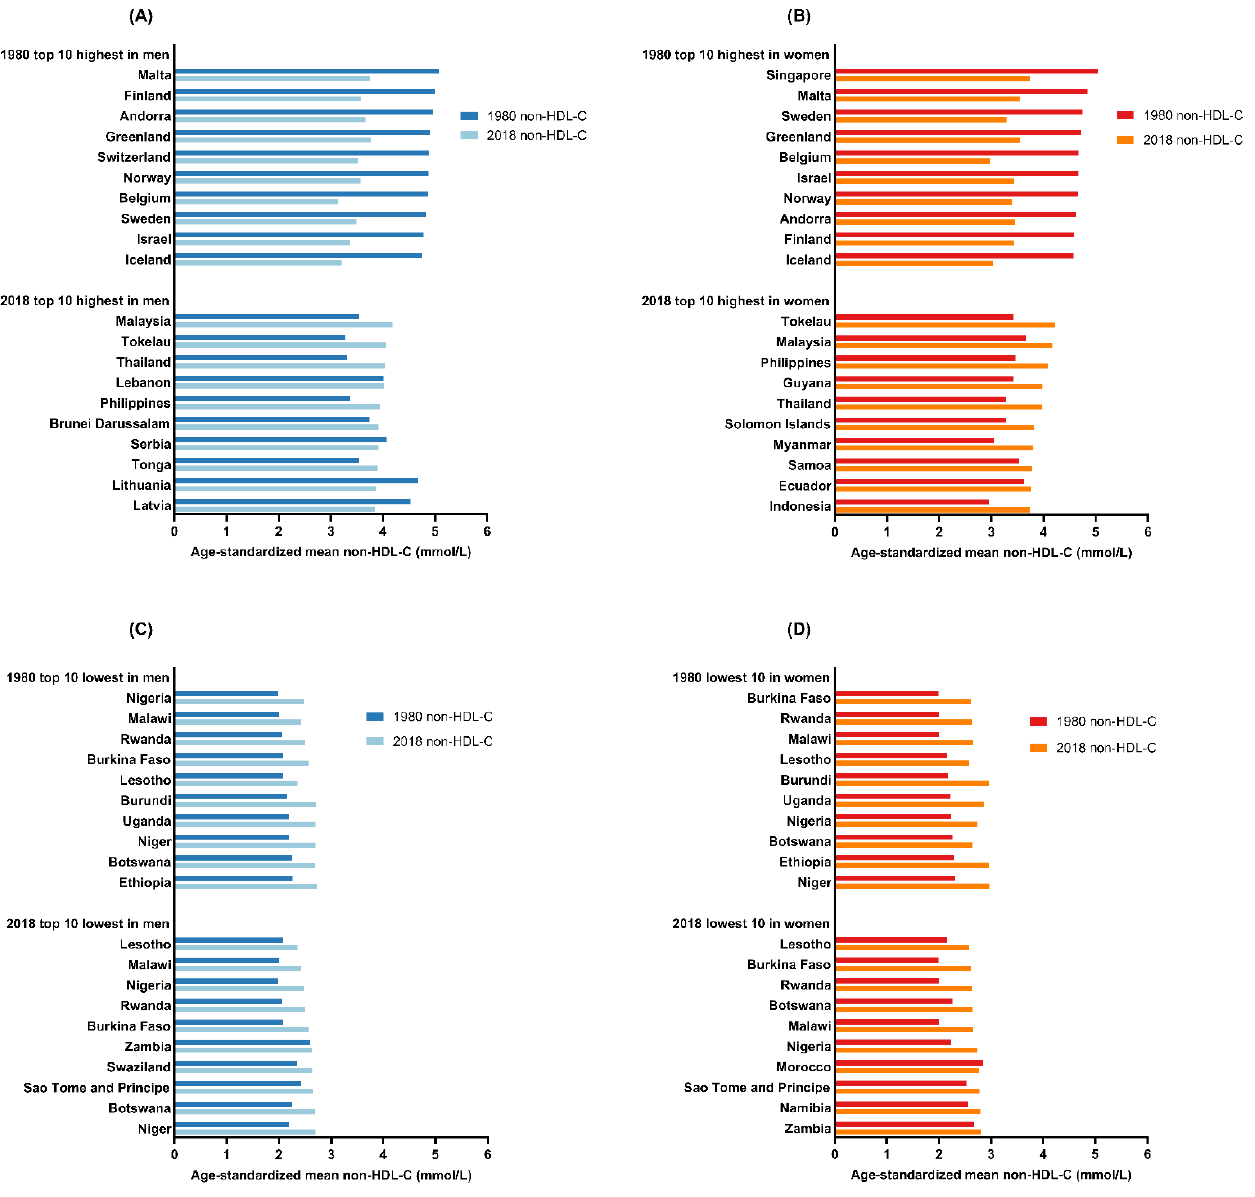
Figure 1. Top 10 countries with the highest and lowest age-standardized mean non-HDL-C levels in 1980 and 2018 for men and women. ( A ), Top 10 countries with the highest age-standardized mean non-HDL-C in men. ( B ), Top 10 countries with the highest age-standardized mean non-HDL-C in women. ( C ), Top 10 countries with the lowest age-standardized mean non-HDL-C in men. ( D ), Top 10 countries with the lowest age-standardized mean non-HDL-C for women. Data obtained from NCD-RisC study. Available online: https://www.ncdrisc.org (accessed on 1 July 2022) [13]. Abbreviations: non-HDL-C, non-high-density lipoprotein cholesterol.